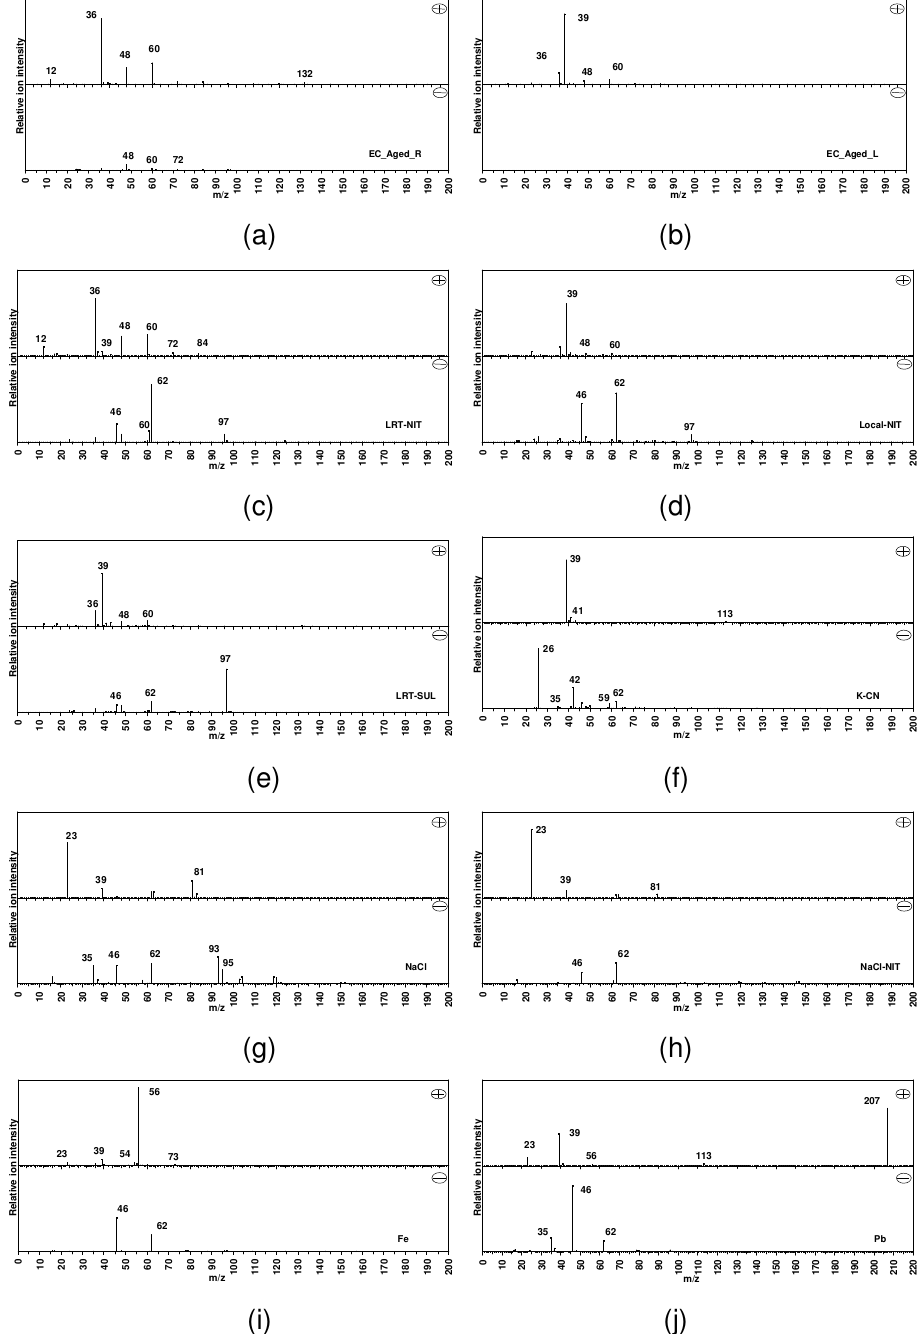
Figure 2. Average mass spectra of the 10 single-particle types observed at both the RS and UB sites.